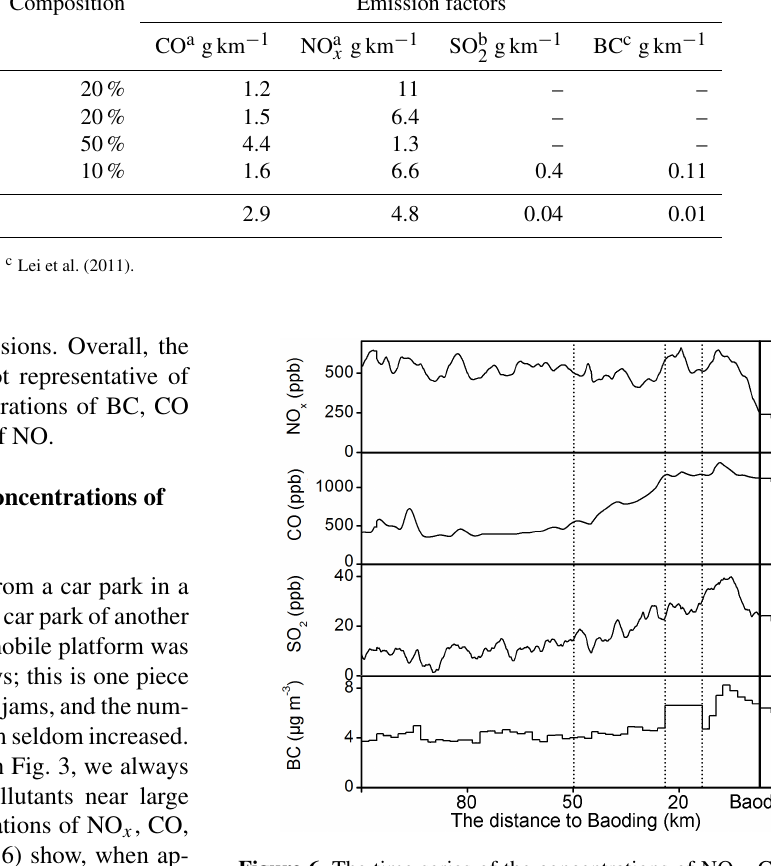
Table 3. Estimated weighted vehicular emission factors of CO, NO x , SO 2 and BC during mobile measurements in Hebei province, China. Vehicle type